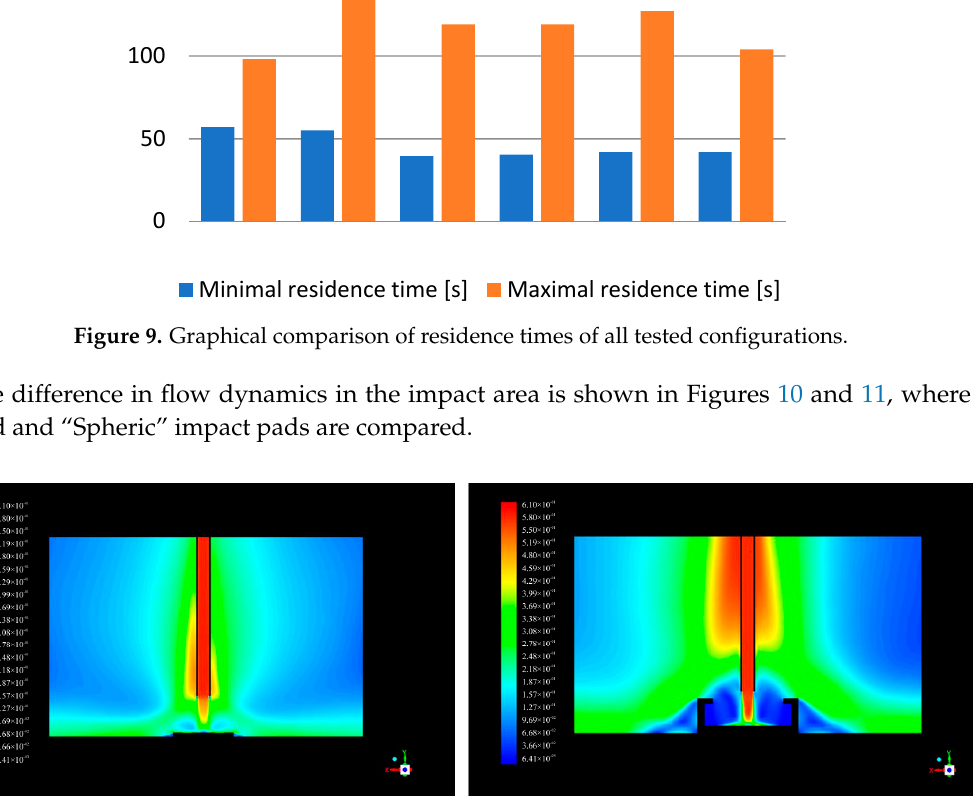
Table 1. Comparison of residence times for all tested configurations.